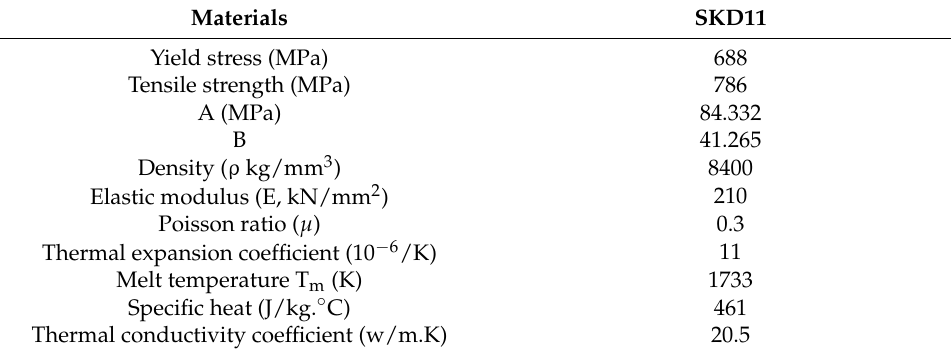
Table 2. Material properties of SKD11 alloy steel